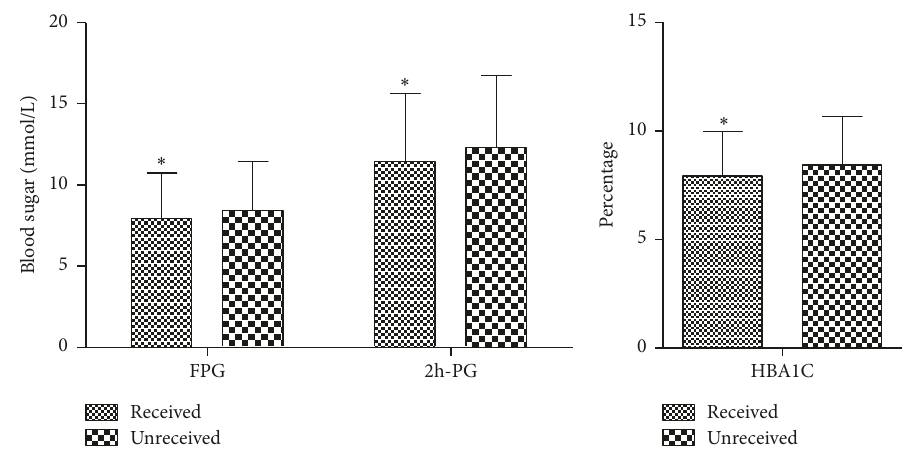
Figure 1: Influence of the MNT education on blood glucose levels. ∗ Significant difference compared to the unreceived MNT group, 𝑃 < 0.001 .